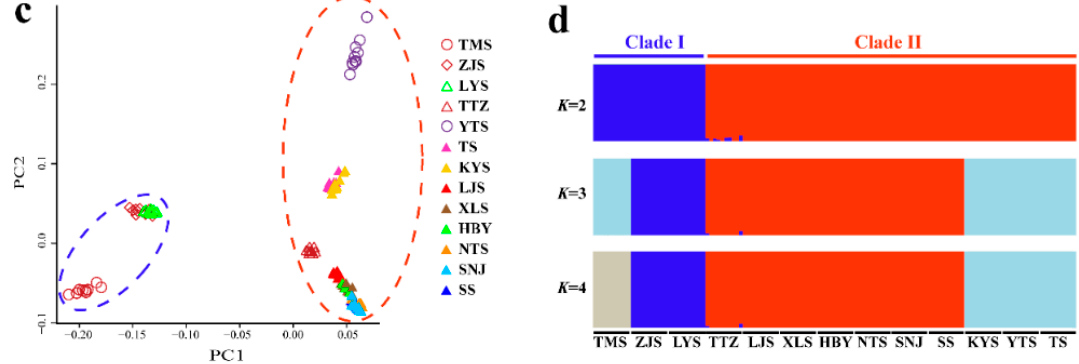
Figure 7. Population genetics analyses of P. glacialis based on genotyping-by-sequencing (GBS) data. ( a ) Sampling sites in this study representing a total of 129 individuals from 13 populations; ( b ) Neighbor joining (NJ) tree constructed using p -distance between individuals representing 13 populations; ( c ) Principal Components 1 and 2 for all individuals; ( d ) population genetic structure based on genomic SNPs. Each vertical bar represents one individual, and the length of each colored segment indicates the proportion of the individual genome inferred from ancestral populations ( K = 2–4).